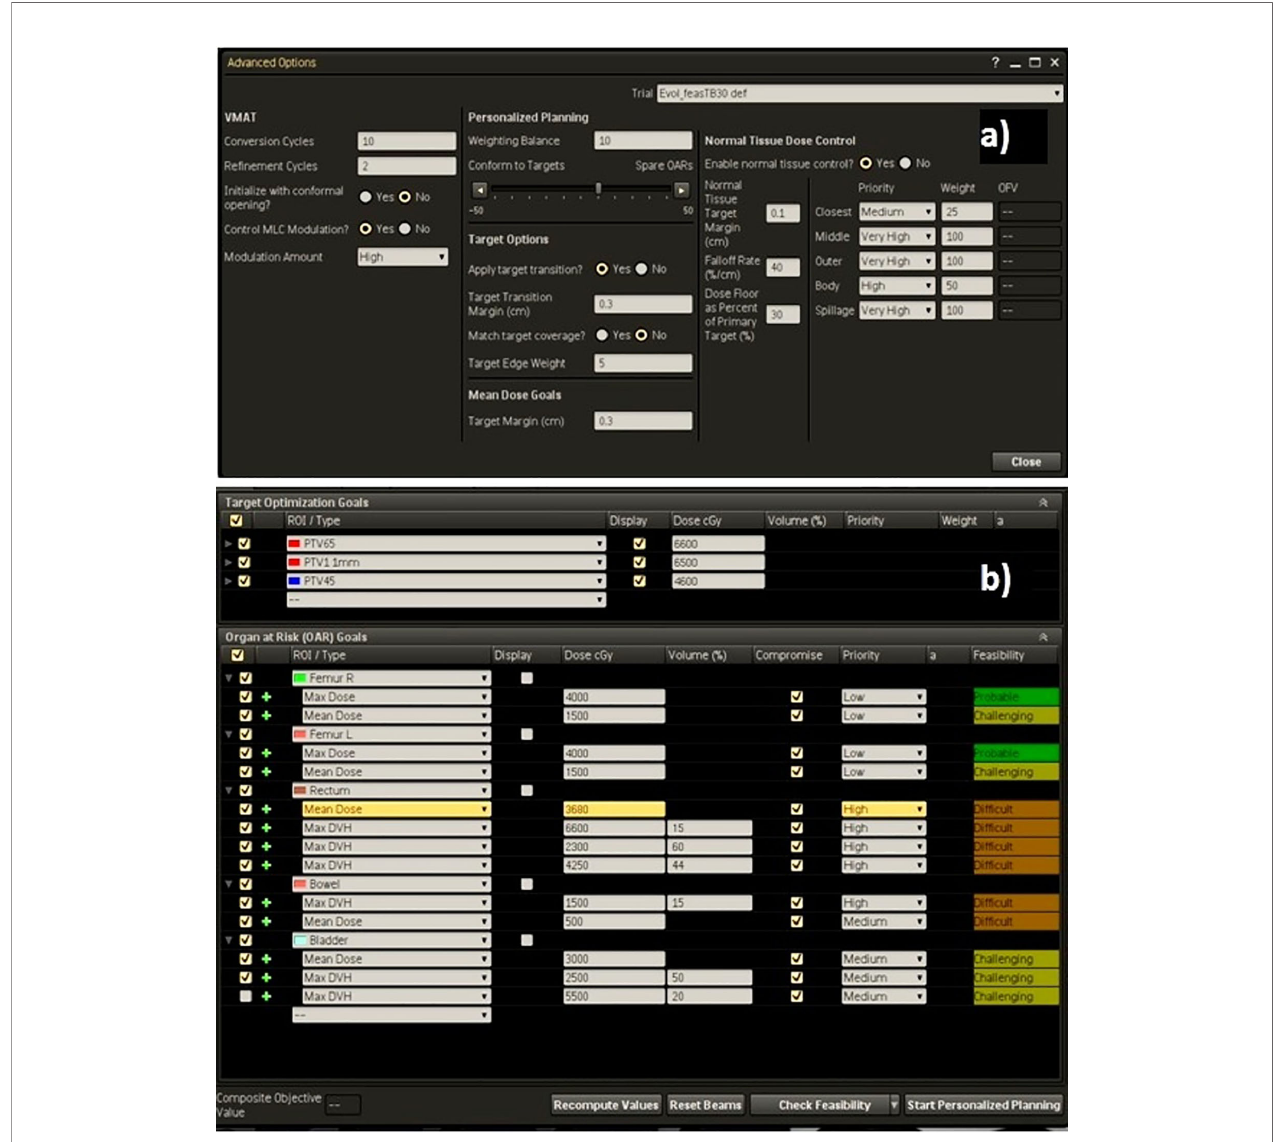
FIGURE 2 | (A) Advanced settings template and (B) dose objectives for PTVs and OARs for a high-risk